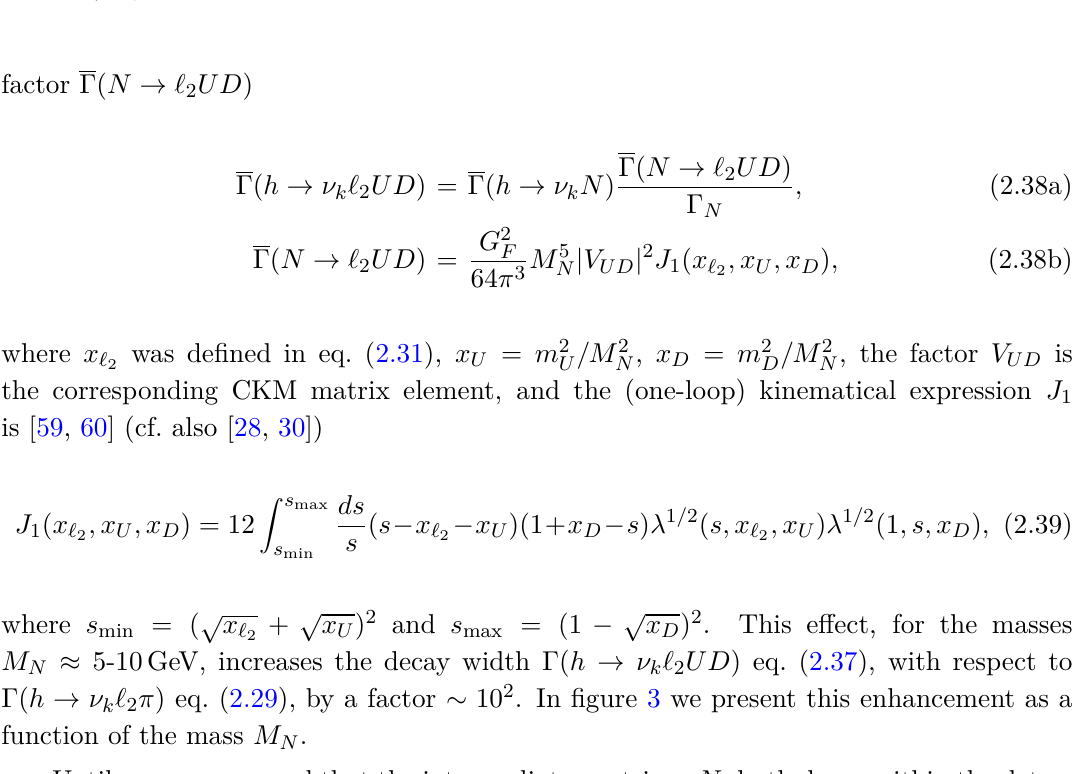
Figure 3 . The enhancement ratio Γ( N → ‘ − Majorana neutrino N j , for ‘ 2 = τ . The sum over U = u, c and D = d, s is implied whenever kinematically allowed. The used values of the quark masses are: m u = m d = 3 . 5 MeV; m s = 105 MeV; m c = 1 . 27